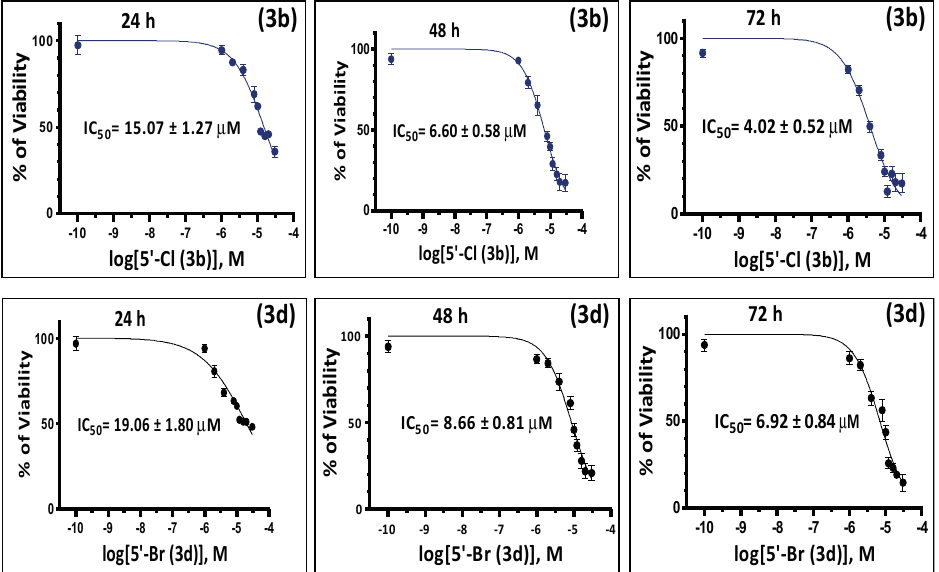
Figure 3. The IC values of compounds 3b and 3d determined in K562 cells at different 50 time points. K562 cells were treated with varying concentrations of compounds 3b or 3d (0.0 to 40.0 µM) for different periods of time (24, 48 and 72 h) and their antiproliferative activity was analyzed by MTT viability assay. The sigmoidal curves shown were obtained by plotting the percentages of viability (mean ± SD of three independent experiments, three replicates for each concentration in every experiment were used) versus logarithmic molar concentrations of the test compounds at the three different time points, and the IC was determined using a non-linear regression analysis of GraphPad Prism 6